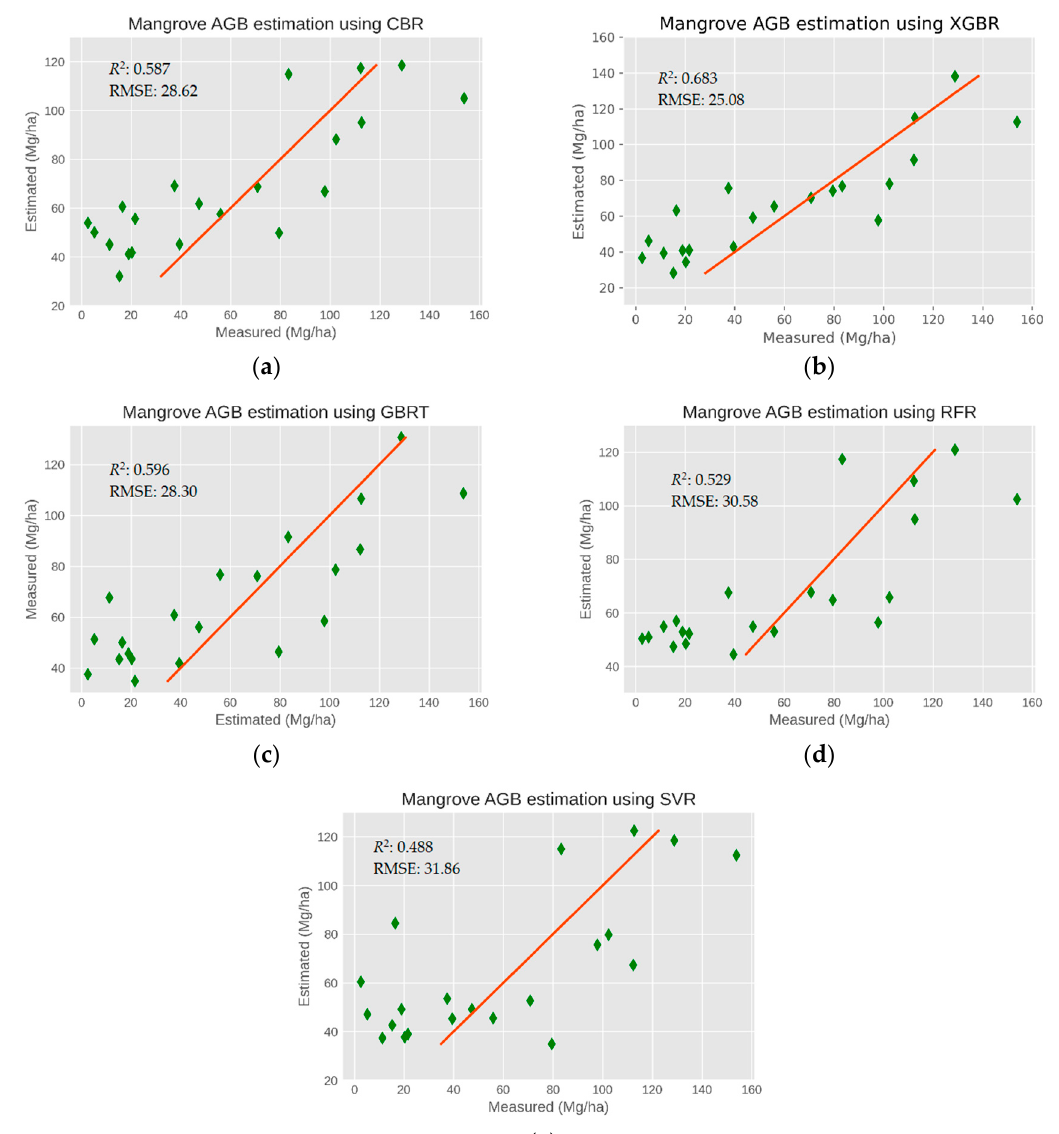
Figure 4. Comparison of the predictive performances of the ML methods for mangrove AGB estimations using multi-sensors in the testing phase. ( a ) CBR, ( b ) XGBR, ( c ) GBRT, ( d ) RFR, ( e ) SVR.